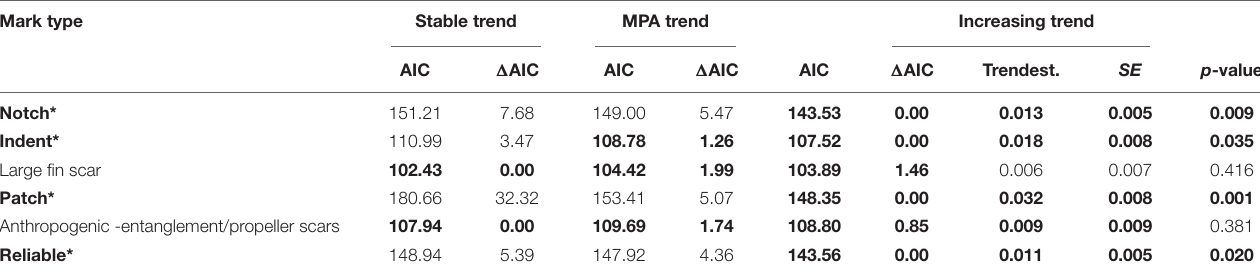
TABLE 4 | Summary of binomial generalized linear regression models (GLMs) used to assess whether the proportion of marked individuals had either (a) remained stable, (b) differed between years occurring prior to or after the MPA or (c) increased over time